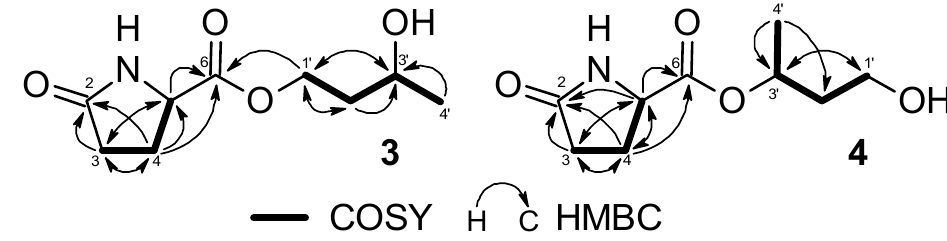
Figure 3. HMBC and COSY correlations of 3 and 4.